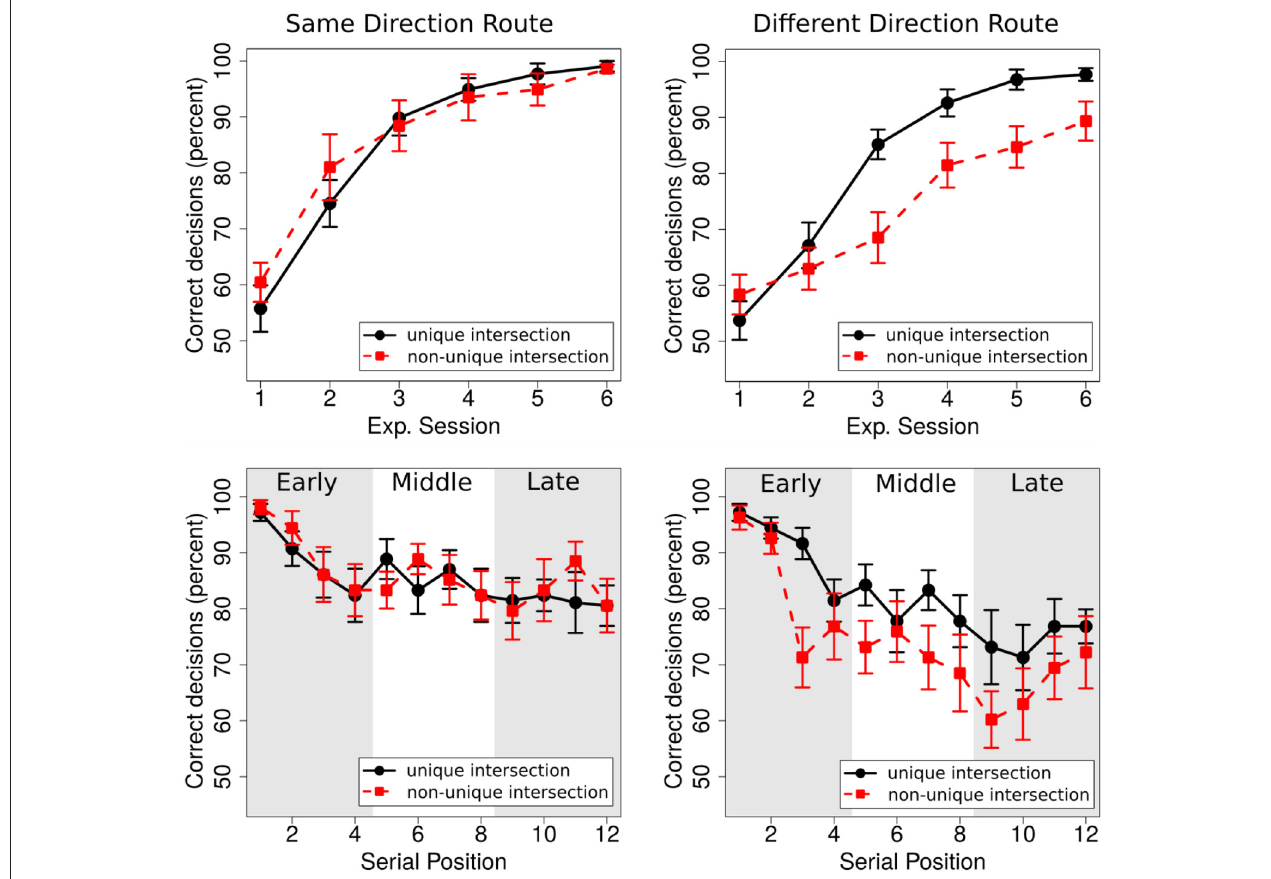
FIGURE 3 | Top row: Performance for unique and non-unique intersection in the same direction route (left) and the different direction route (right). Lower row: Performance as a function of serial position for the same direction route (left) and the different direction route (right). For the analysis, intersections were classified as early, middle, or late along the